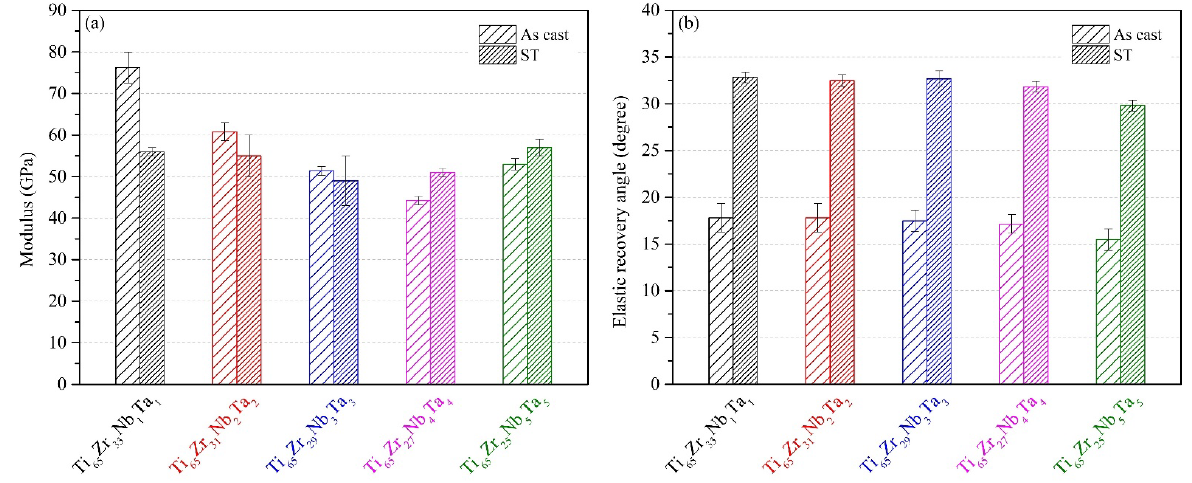
Figure 8. Elastic properties of the Ti–Zr–Nb–Ta MEAs obtained through three-point bending tests: ( a ) elastic modulus and ( b ) elastic recovery angle.